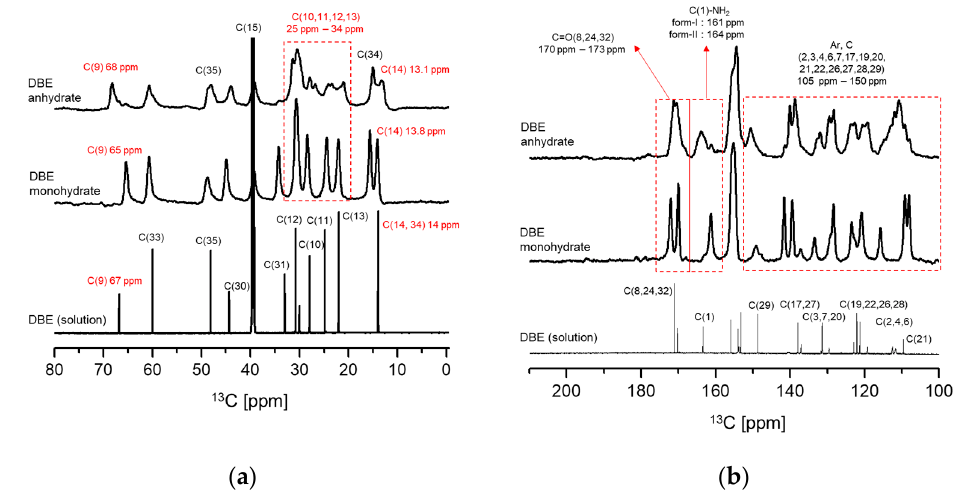
Figure 6. Solution-state 13 C-NMR (DMSO-d 6 ) and Solid-State CP/MAS 13 C-NMR data of DBE crystal forms ( a ) 0 ppm–80 ppm, ( b ) 100 ppm–210 ppm (Numbers on the peaks are related to numbers